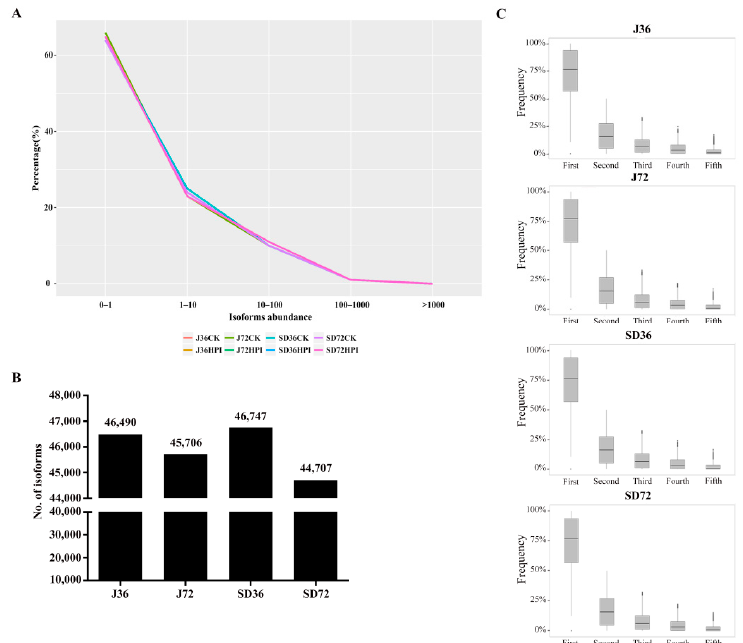
Figure 1. The number and abundance distribution of isoforms in apple. ( A ) The distribution of isoforms abundance in eight samples overlapped with two biological replicates. The isoforms abundance was calculated with FPKM. ( B ) The number of isoforms in J36, J72, SD36, SD72 groups. ( C ) Frequency of the top five most abundant isoforms in each gene across J36, J72, SD36, SD72 groups.